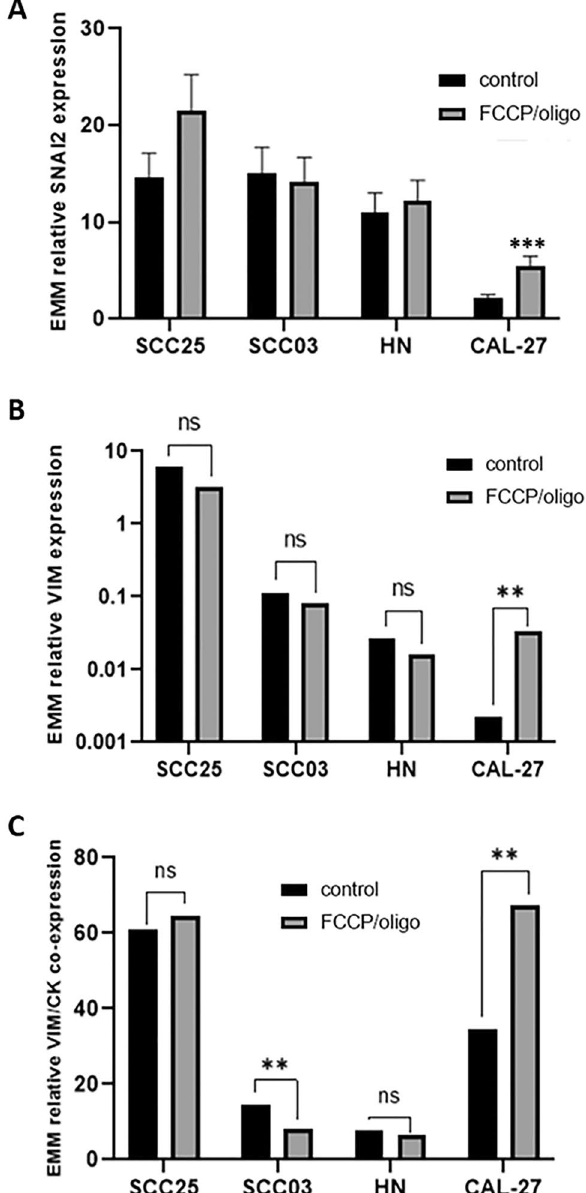
Figure 2. Relative SNAI2 ( A ), vimentin (VIM; B ) expression, and percentage of vimentin/cytokeratin double positive cells ( C ) in response to FCCP/oligomycin (EMM: Estimated marginal mean; Bars: SEM; *p < 0.05, **p < 0.01, ***p < 0.001).